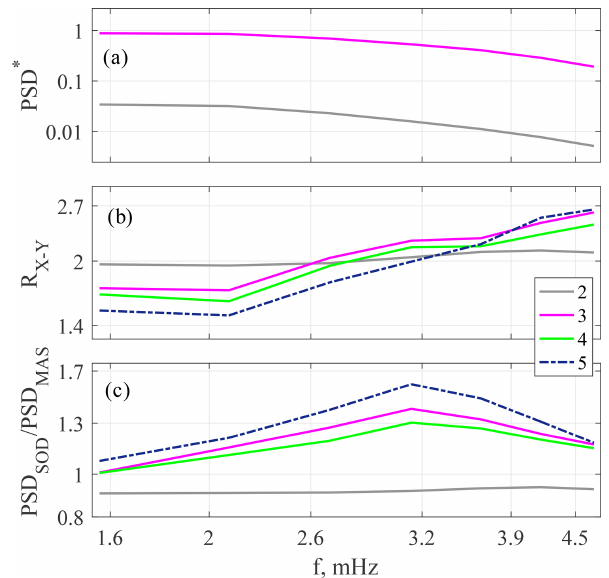
Figure 10. Frequency histogram for b X (group 2) and (cid:49) fo F2 (group 3) fluctuations (a) and for the parameter δ = log ((cid:49) f 2 , 0 /(cid:49) f 2 ,R ) , where (cid:49) f 2 , 0 and (cid:49) f 2 ,R are the mean values of (cid:49) f 2 for simulta- neous and random intervals, respectively (b) .